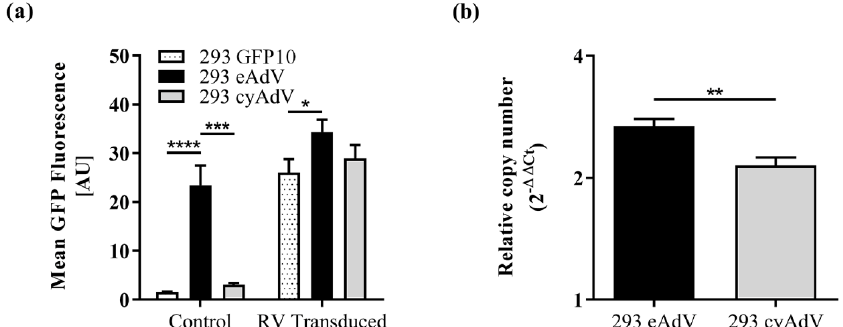
Figure 5. Comparison of GFP10 and GFP11 levels in 293 eAdV and 293 cyAdV sensor cells. ( a )